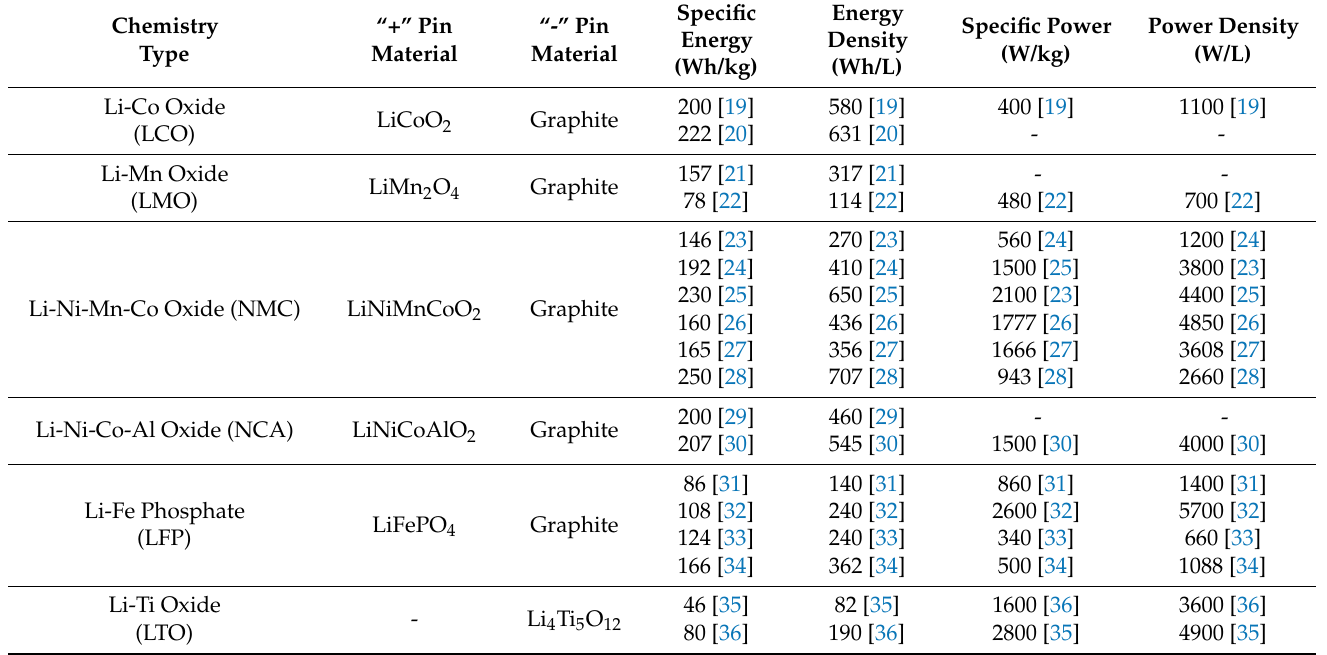
Table 2. Selection of most common lithium-based chemistry types on the market